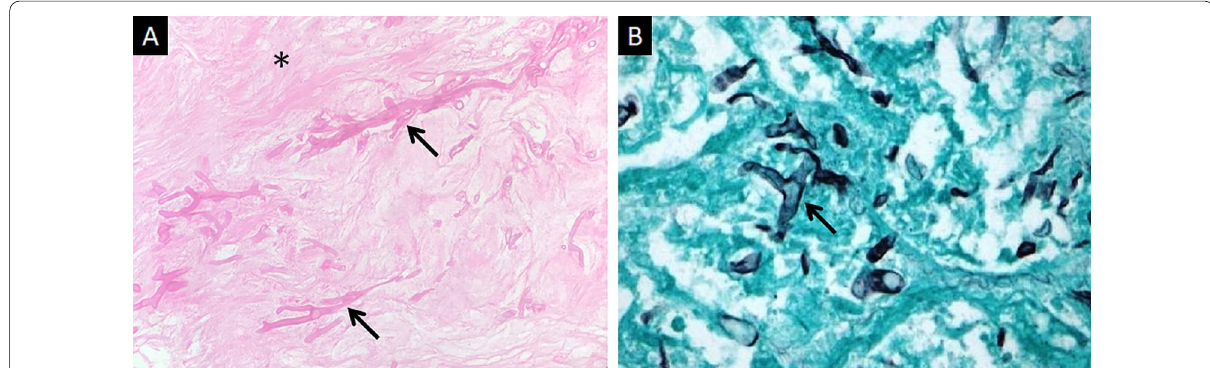
Fig. 3 Histopathological examination of neck tissues following surgical debridement of 2 different patients with ROCM. Haematoxylin and Eosin (HE) staining ( a ) demonstrates broad, branching fungal hyphae (thick arrows) on the background of extensive tissue necrosis (*). Grocott-Gomori methamine silver staining ( b ) relies on oxidation of the polysaccharides within fungal cell walls. The result is black staining of hyphae (thick arrow in b ) against a green counterstain